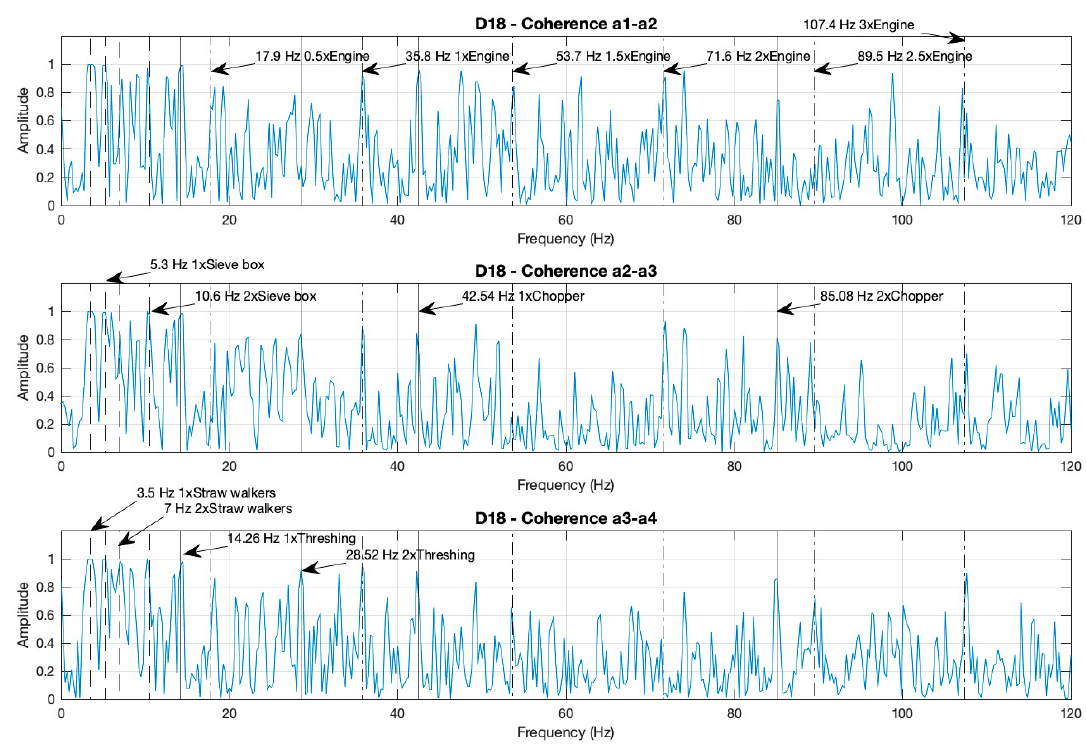
Figure 6. Coherence functions between the combinations of the accelerometers a0–3, placed in the combine harvester, relative to case D18 (the thresher and the chopper both activated and unbalanced, with the motor at maximum RPM).